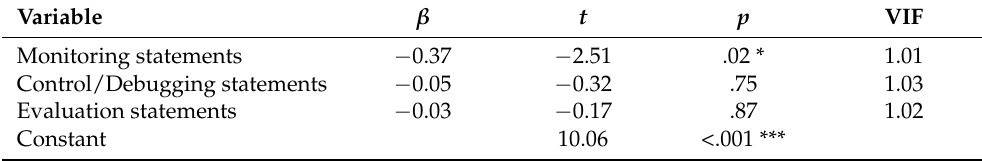
Table 7. Multiple linear regression model predicting performance on the first activity with verbal pro-